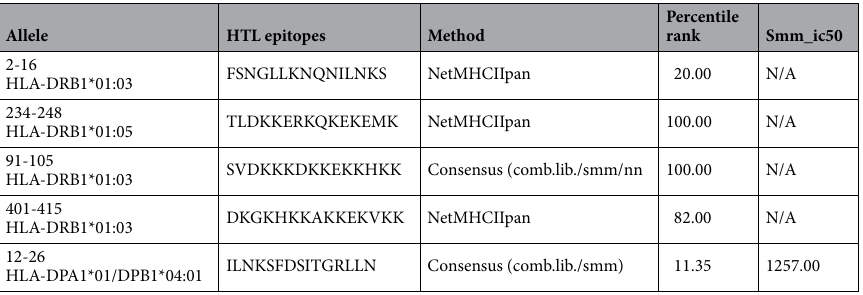
Table 2. List of the top predicted MHC class II peptide from (PfGARP) protein, by IEDB MHC-II server.